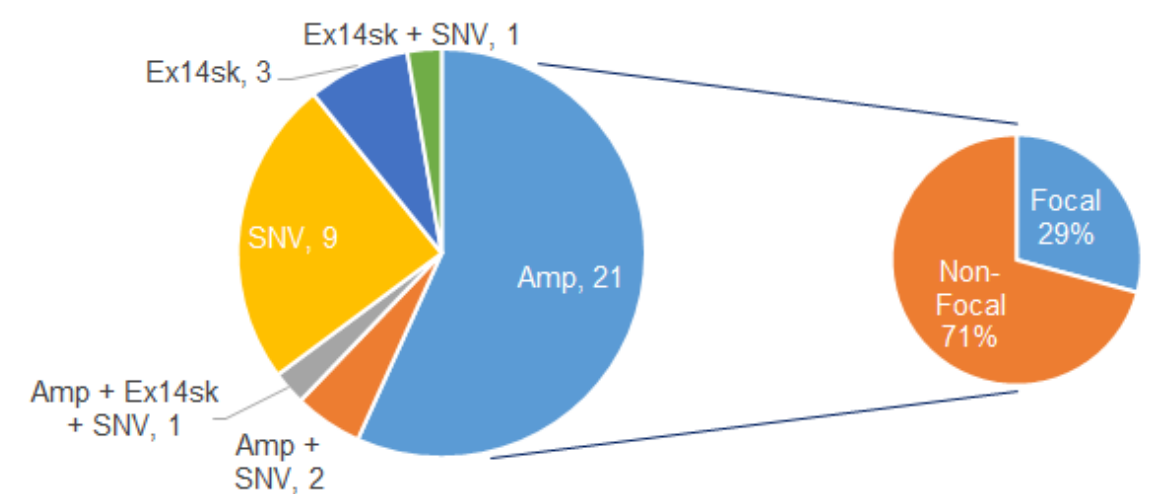
Figure 3. Types of MET alts detected in cfDNA. Among the 291 patients tested before September 2018, 37 (12.7%) had MET alts, according to Guardant360. In 37 patients, 24 patients (64.9%) had amps, 5 (13.5%) had exon 14 skipping, and 13 (35.1%) had SNVs. Among 24 MET amps, we found 17 patients (70.8%) of the non-focal MET amp and 7 patients (29.2%) of the focal MET amp, according to our algorithm.